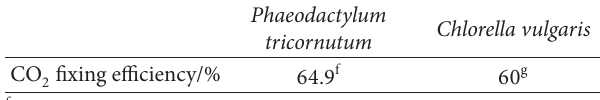
Table 2: CO fixing efficiencies of different algae 2